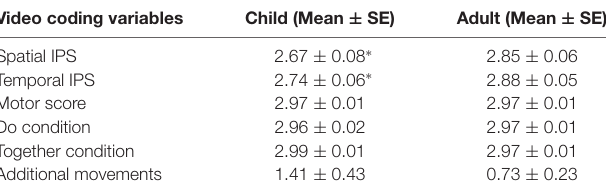
TABLE 2 | The quality of interpersonal synchrony (IPS) in the TD children and adults. Video coding